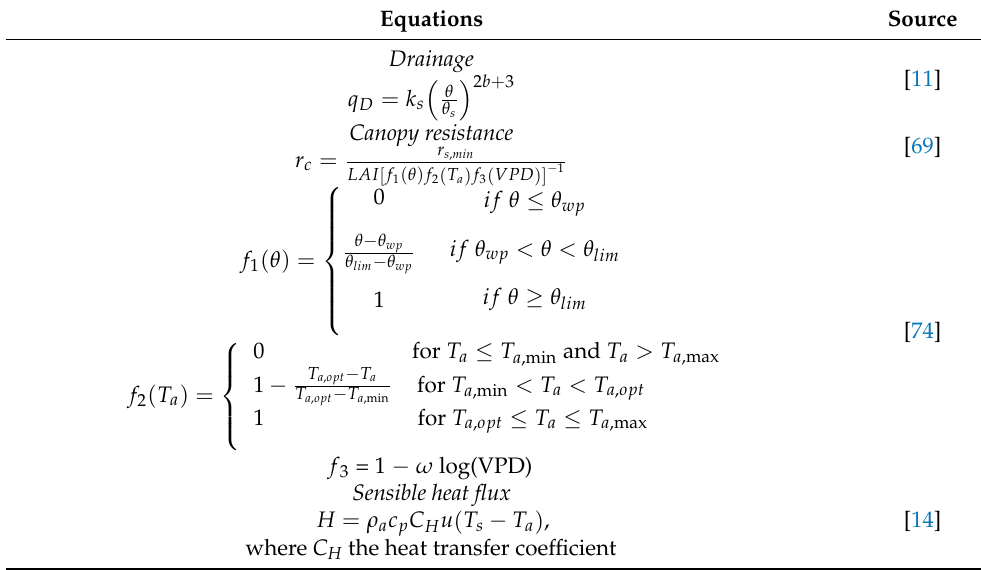
Table 1. Equations of drainage ( q D ), canopy resistance ( r c ) with stress functions of soil moisture ( θ